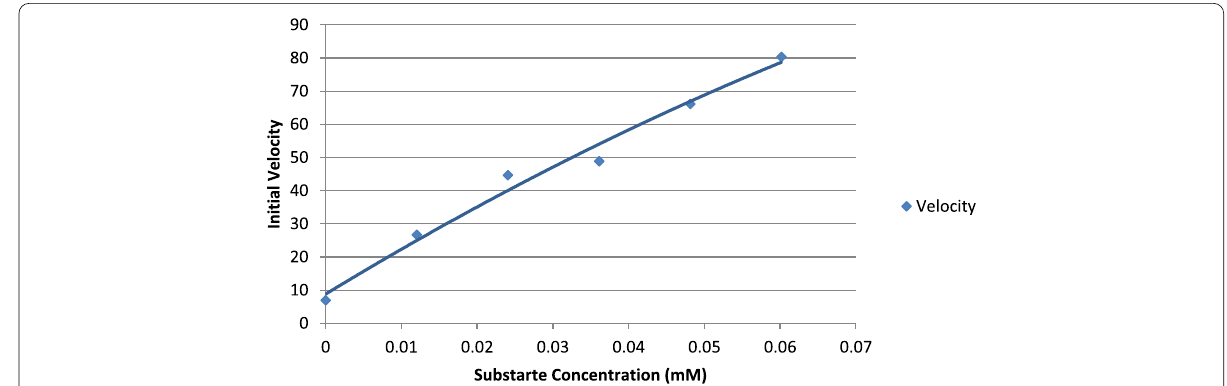
Fig. 6 Initial reaction rate vs substrate concentration